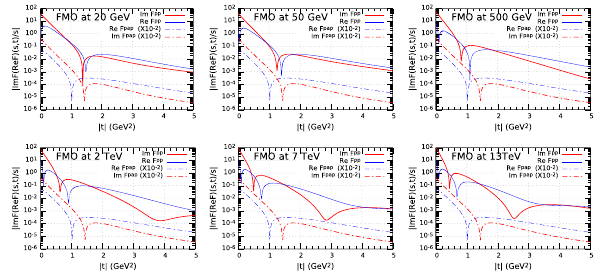
Fig. 12 Partial contributions of the real and imaginary parts of even and odd terms to pp and ¯ pp scattering amplitudes at various energies